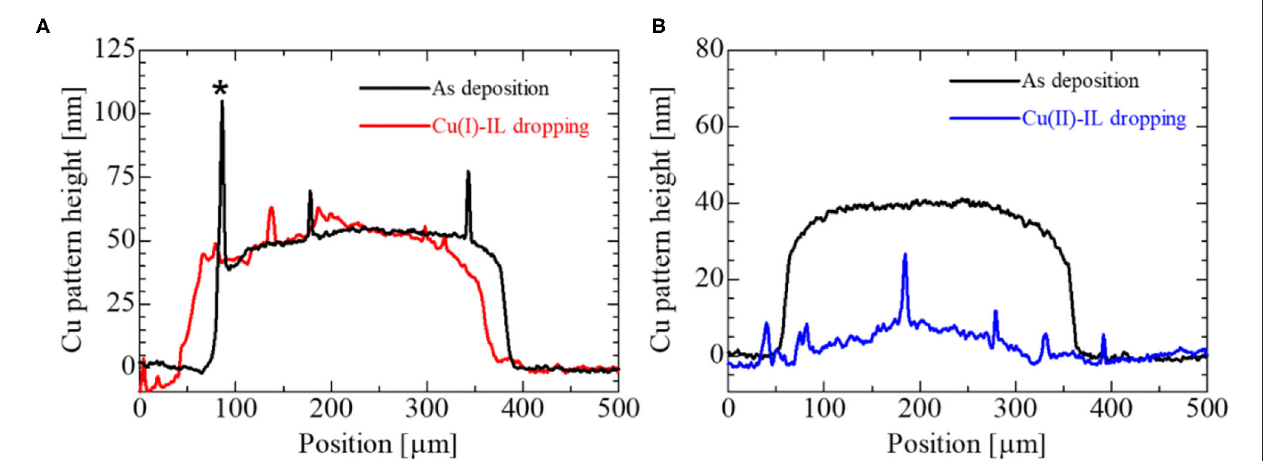
FIGURE 3 | The surface profiler results for (A) Cu(I)-IL and (B) Cu(II)-IL dropped onto the Cu pattern. The red curve in (A) is the surface profile measured along the red horizontal line in Figure 2E . The blue curve in (B) correspond to the surface profile along the blue horizontal line in Figure 2H . The black lines are the surface profiles before the Cu patterns are immersed in the IL. Note that the spiky peak shape at the edge of the Cu pattern plotted by the black line in (A) marked with an asterisk (*) is thought to be a side-wall fence structure formed during the mask-through sputtering process. The profiles for the Cu patterns dipped in IL were measured after removing IL by acetone and ethanol.